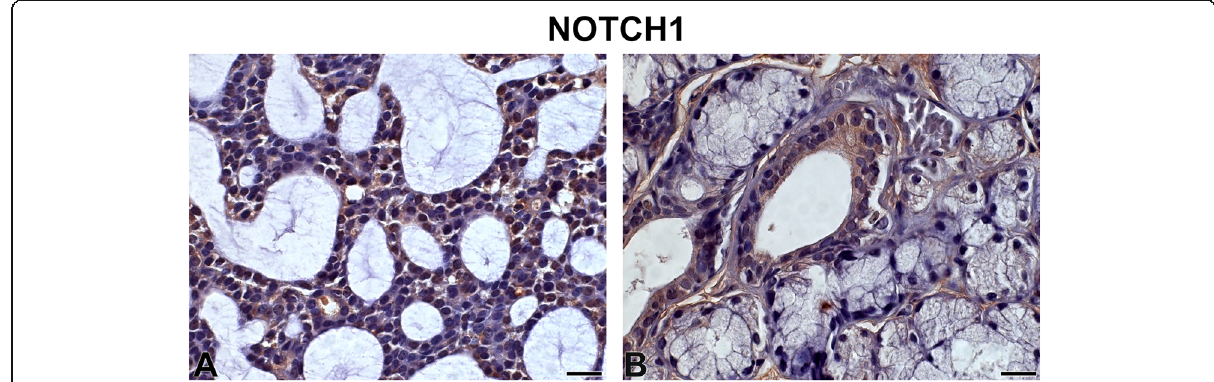
Fig. 2 NOTCH1 Legend: Immunostaining of NOTCH1 in adenoid cystic carcinoma ( a ) and normal-looking salivary gland ( b ). Immunoperoxidase. Scale bar: 20 μ m